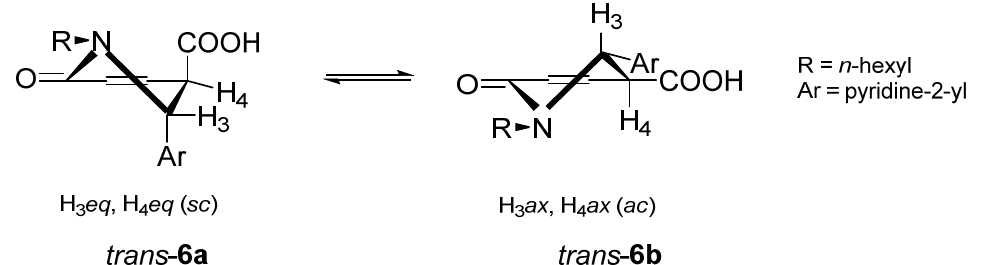
Table 1. Relative energy differences in (kcal/mol) and the dipole moments (in D) for the studied conformers.